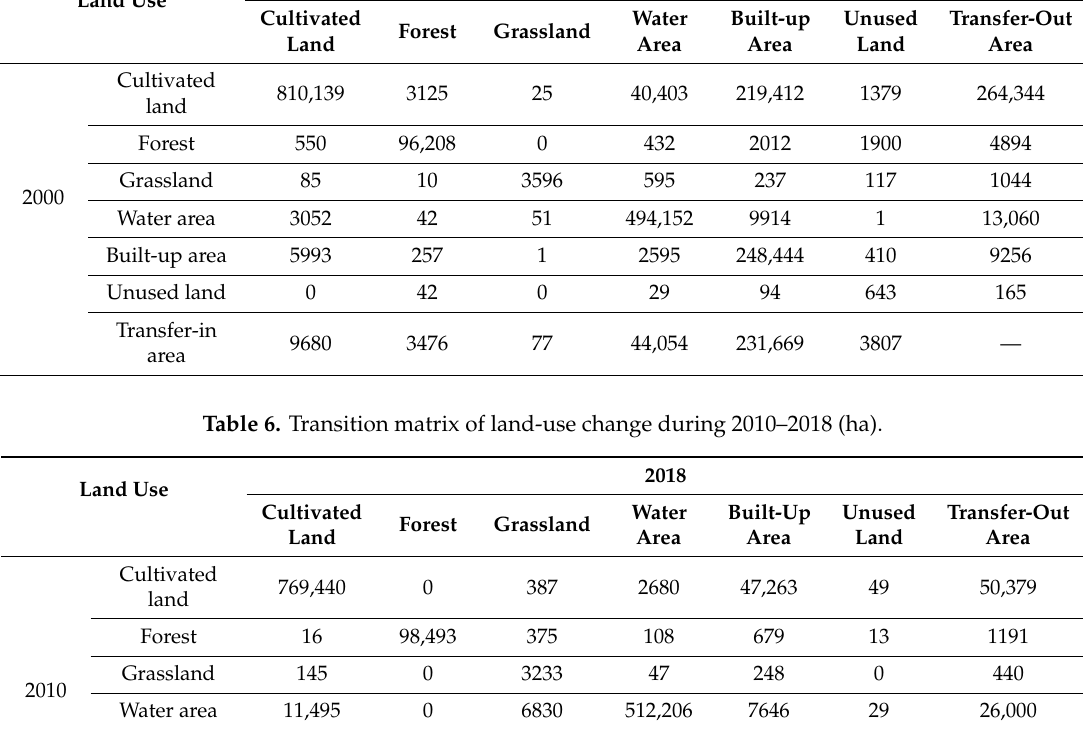
Table 5. Transition matrix of land-use change from 2000–2010 (ha).